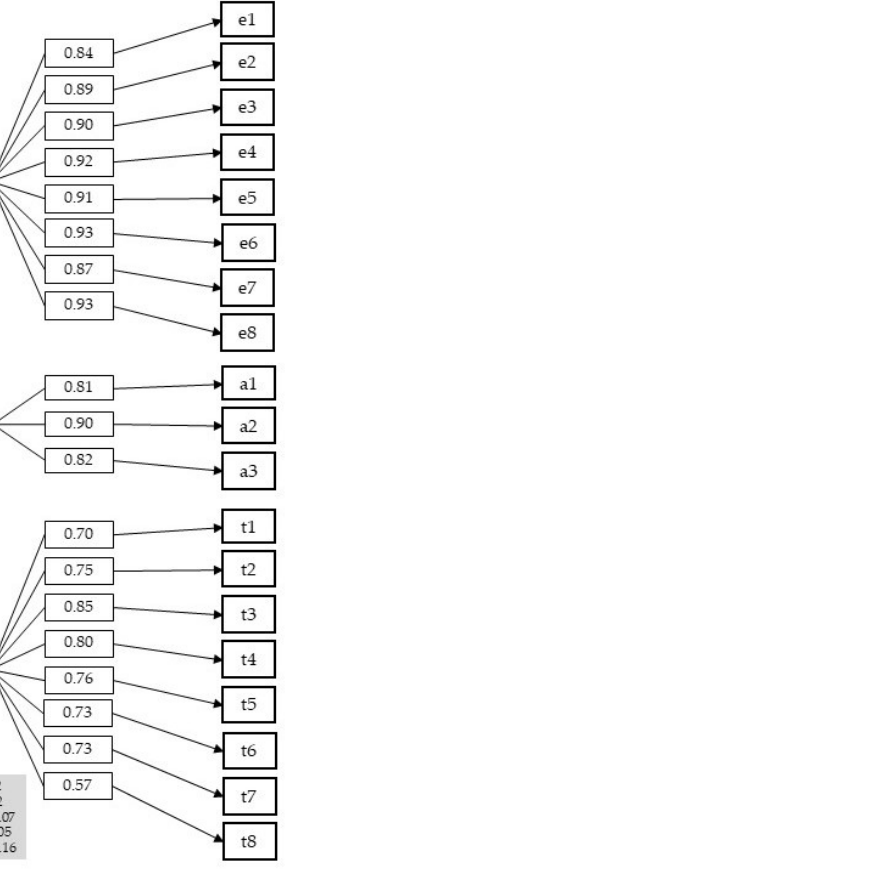
Figure 1. BEAT Questionnaire CFA Model. Note: p = 0.000. B: Organizational Well-Being. E: Focus in Leadership. A: Positive Environments. T: Meaningful